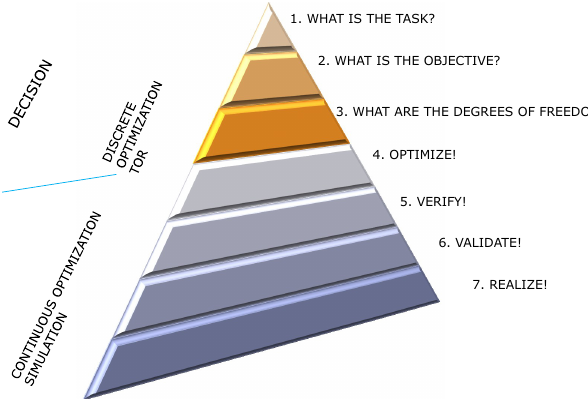
Figure 7. The seven steps of the TOR